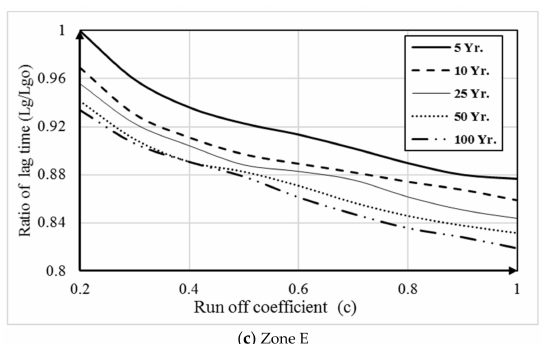
Figure 11. Relationship between runo ff coe ffi cient (C) and lag time of zones A ( a ), C ( b ) and E ( c ).